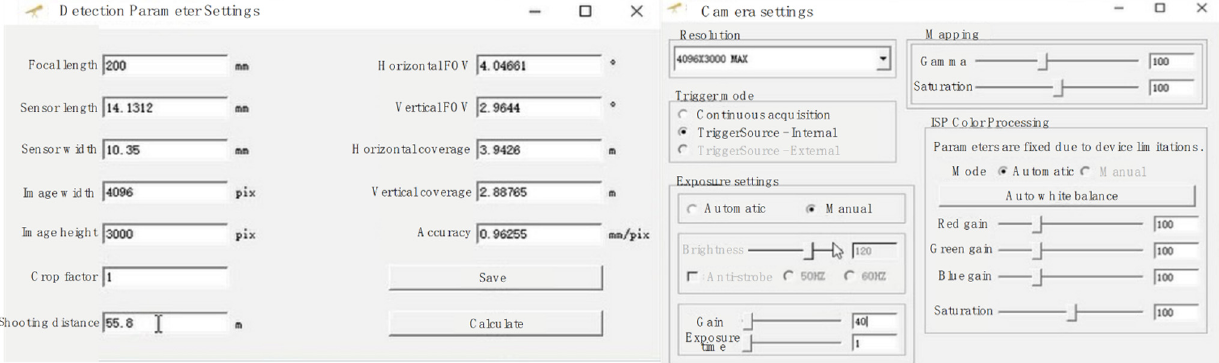
Figure 19. Main settings for the software.